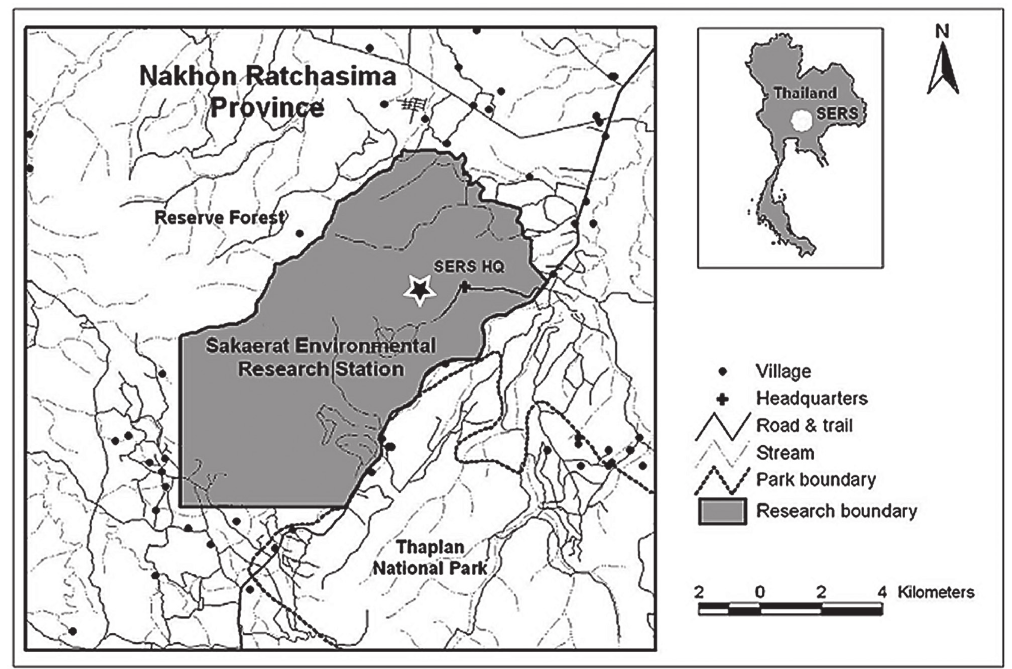
Fig. 2. Map of Sakaerat Biosphere Reserve in Thailand (modified from Trisurat 2010). The new record of Umborotula bogorensis (Weber, 1890) is indicated by a